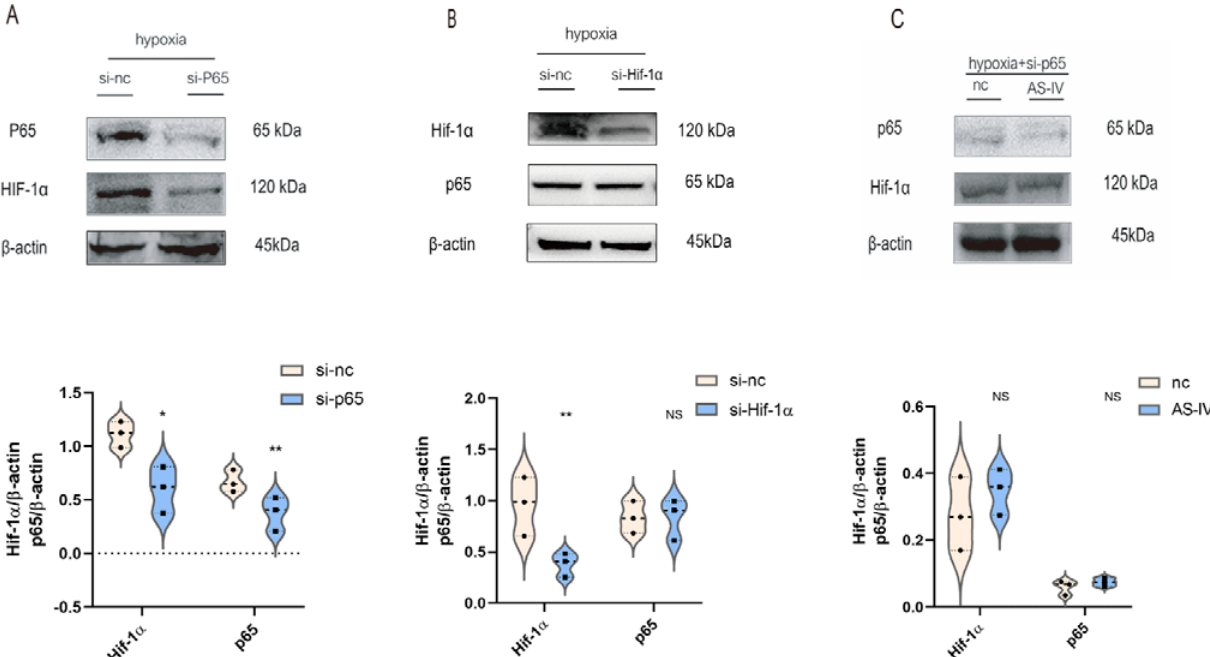
Figure 5. AS-IV regulated Hif-1 α is mediated by p65 under hypoxia. ( A ) Western blotting analysis of p65 and Hif-1 α after transfection of p65 siRNA or si-nc. ( B ) Western blotting analysis of p65 and Hif-1 α after transfection of Hif-1 α siRNA or si-nc. ( C ) Western blotting analysis of p65 and Hif-1 after transfection of p65 siRNA with or without AS-IV; n = 3 in each group, NS, no significance, * p < 0.05, ** p <